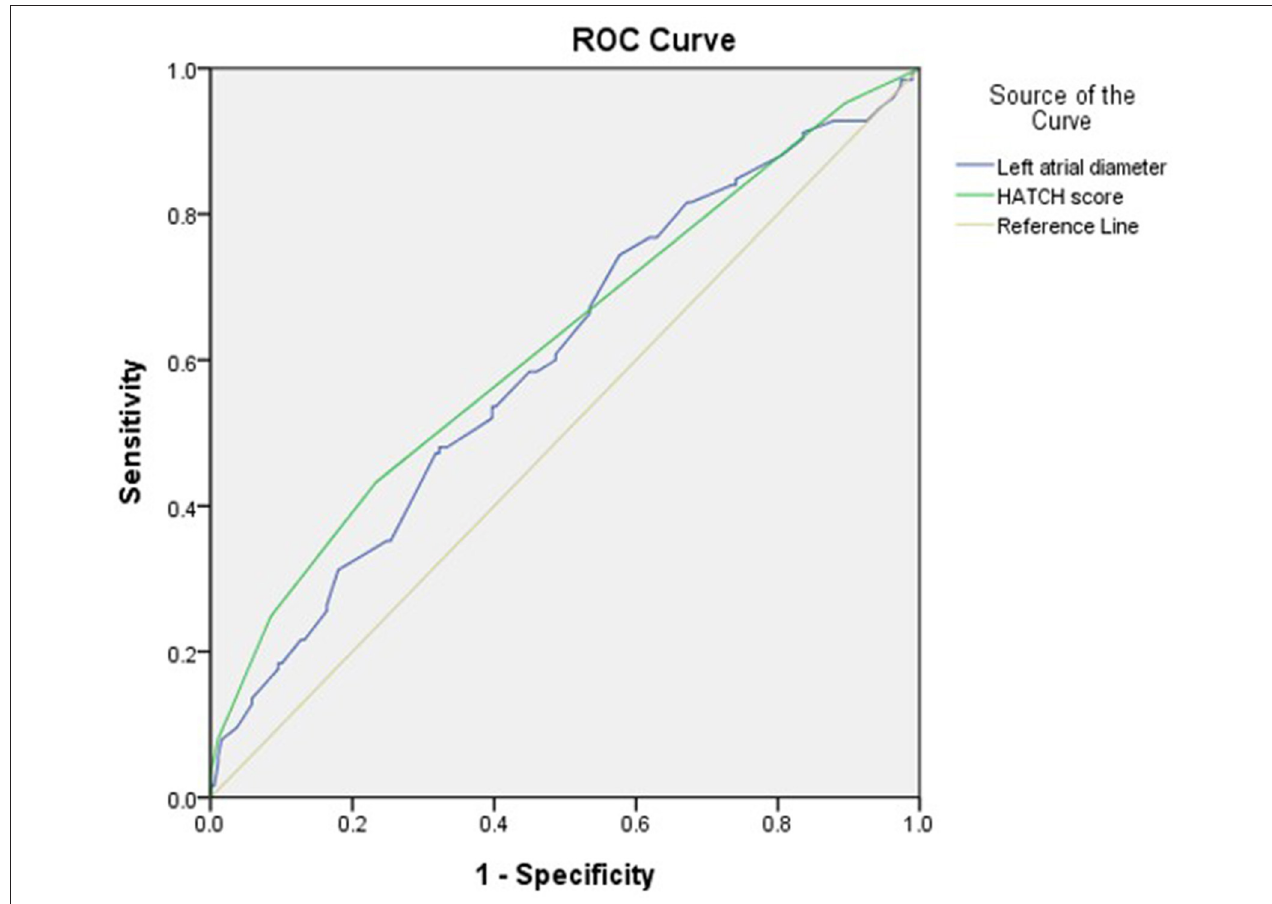
FIGURE 3 | Receiver-operating characteristic curve analysis of factors in patients with CIEDs with subsequent AHRE ≥ 3min. Left atrial diameter (cm): the highest Youden index: 4.0cm, AUC, 0.600; 95% CI, 0.536–0.664; p = 0.003. HATCH score: the highest Youden index: 3, AUC, 0.624; 95% CI, 0.560–0.688; p <